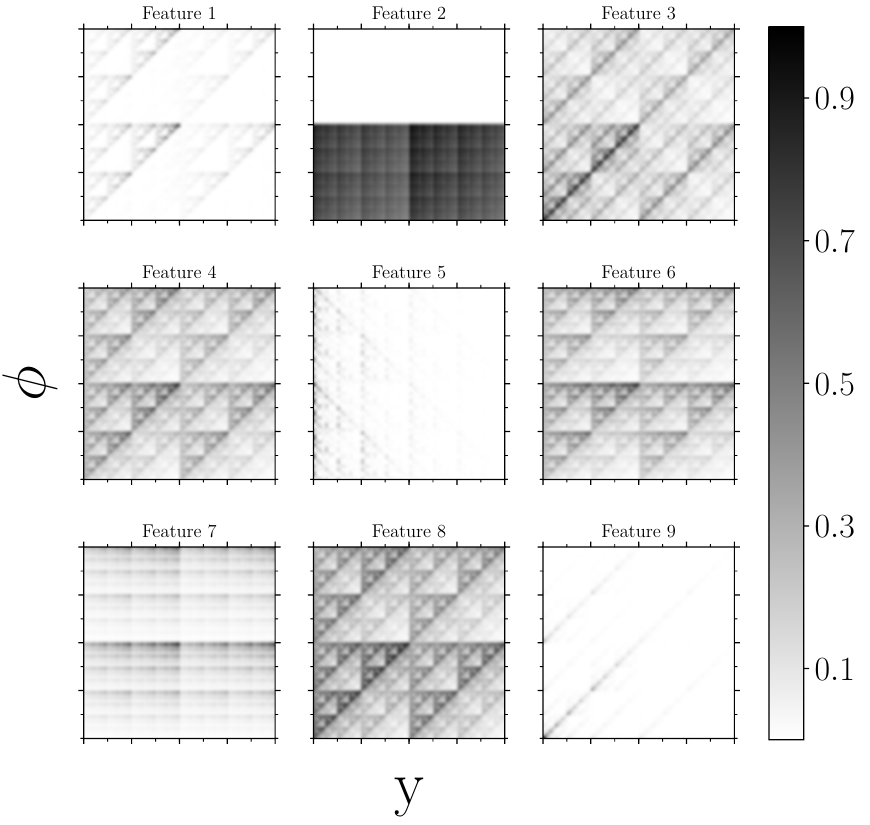
Figure 12 . Features encoded in model k 2